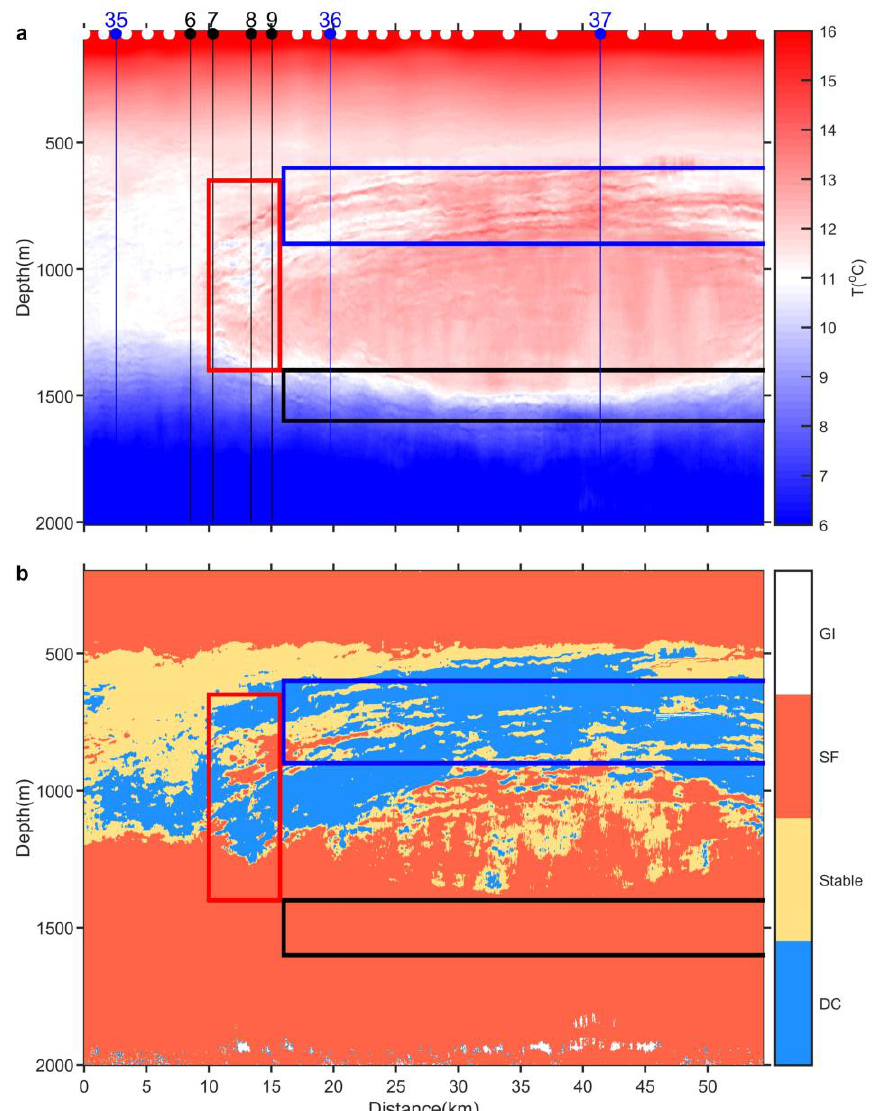
Figure 7. ( a ) The inverted temperature section. The red, blue and black rectangles represent the left, top and bottom edge areas of this meddy, which are found to be subject to lateral thermohaline intrusions, diffusive fluxes and salt fingering mixing, respectively. White dots represent the XBT locations along the cruise, while black dots represent XBTs near the frontal area. Blue dots represent three CTD casts deployed before and after the seismic cruise. ( b ) The Turner angle section estimated from the inverted temperature-salinity sections. GI = gravitational instabilities. SF = salt fingering, DC = diffusive convection. Stable stands for the stable stratification.